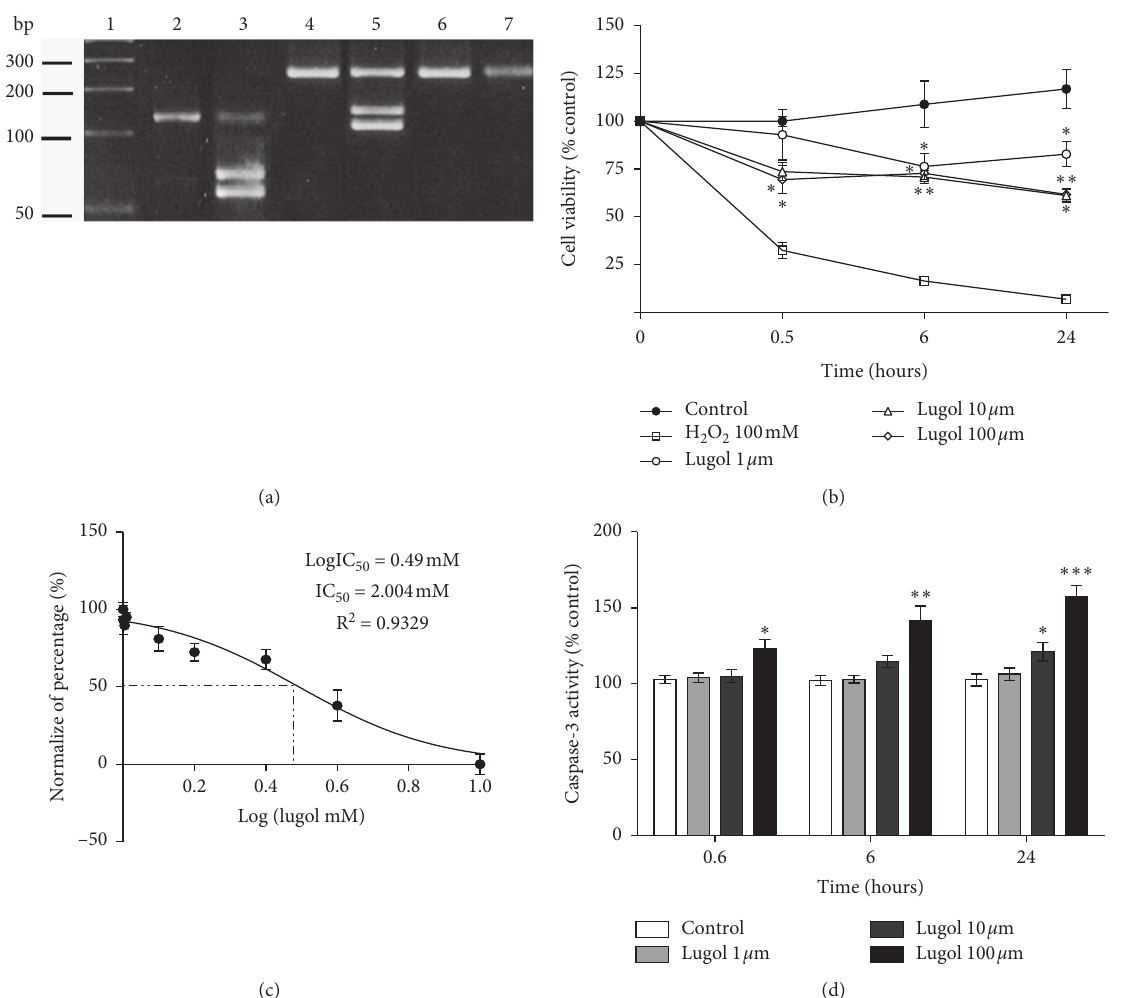
Figure 1: Expression of mRNA iodide transporters and inhibitory effects of lugol on mature 3T3-L1 adipocytes’ growth. (a) Expression of NIS and PEN mRNAs on undifferentiated and differentiated 3T3-L1 (mature adipocytes). Representative electrophoresis (one of the three experiments with similar results is shown). DNA ladder (1), NIS amplicon (2), NIS plus SmaI (3), PEN (4), PEN plus SacII (5), and GAPDH as internal control (6-7). (b) Mature 3T3-L1 adipocytes were treated with lugol (0, 1, 10, and 100 µ M of lugol, n � 9). Cell proliferation was monitored using the MTTassay (see method) at 0.5, 6, 24 h following lugol treatment. OD λ � 570 value in mature 3T3-L1 adipocytes treated without lugol was defined as 100%. ∗ P < 0 . 05; ∗∗ P < 0 . 01; ∗∗∗ P < 0 . 01 compared with the control group (vehicle). (c) Dose-dependent effects of lugol (0–1000 μ g/mL) for 24 h to determine the acute cytotoxicity dose (IC50). (d) After 0.6, 6, and 24h, cellular caspase-3 activity was measured. Fold increase in activity was calculated based on activity measured in control (vehicle) cells. Each assay represents an independent experiment performed in triplicate. Data are presented as mean ± SD. n � 5. ∗ P < 0 . 05, ∗∗ P < 0 . 01, and ∗∗∗ P < 0 . 01 vs vehicle